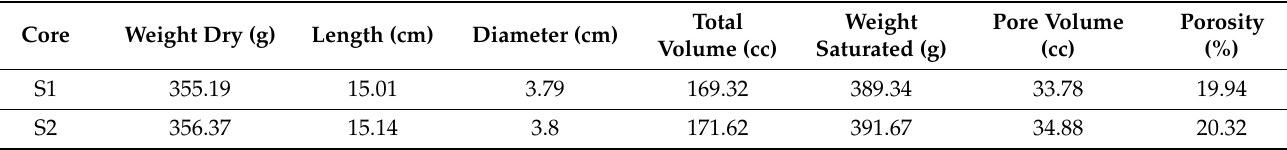
Table 1. Porosity Calculation.